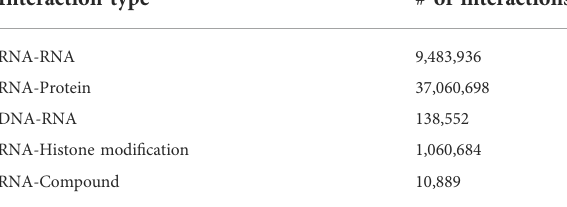
TABLE 2 Number of interactions of each type in the RNAInter database.